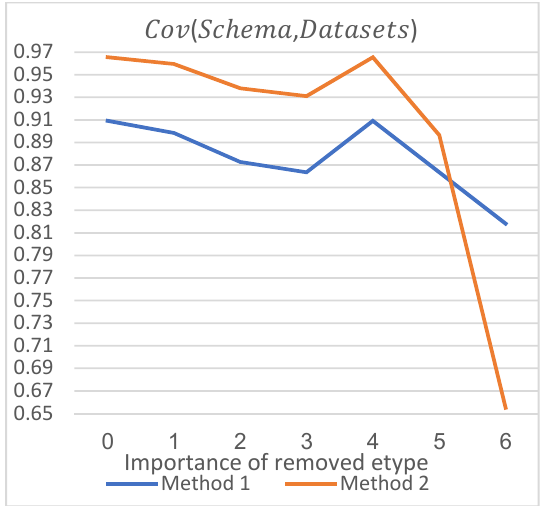
Figure 9. Coverage of Schema to Datasets.